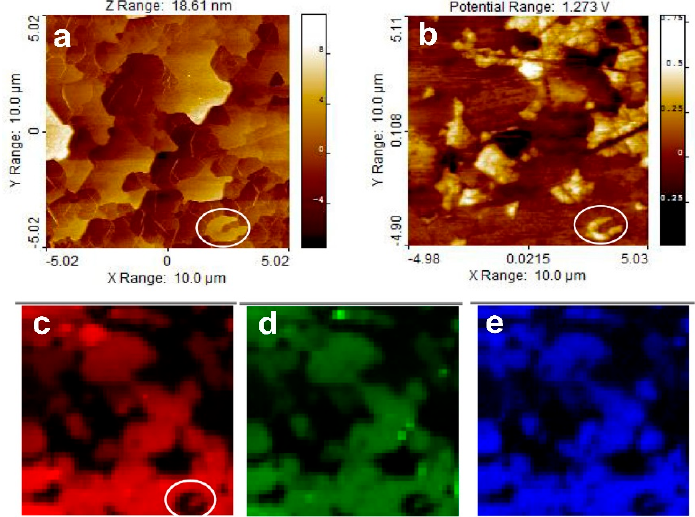
Figure 29. Topography ( a ) and surface potential maps ( b ) of a 10 × 10 µm 2 area of the sample. Spatially resolved Raman spectroscopy maps of the area depicted in ( a ) and ( b ) corresponding to 2D, G and D peak intensities are shown in ( c – e ), respectively. As a guide to the eye, A-like feature highlighted by the white circle in ( a ) and ( b ) can be correspondingly identified on the Raman spectroscopy maps [140].